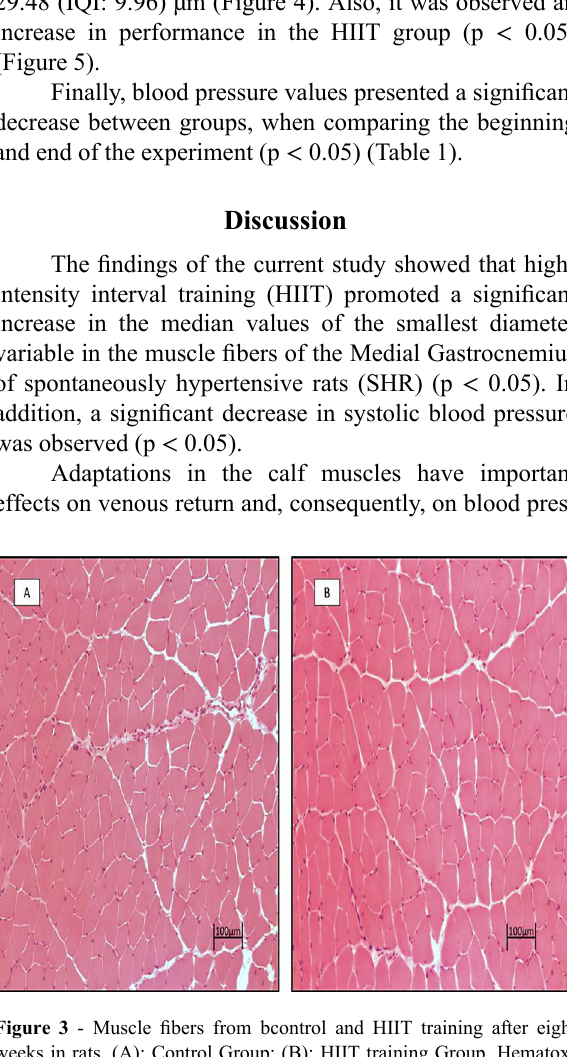
Figure 4 - Comparison between medians between control and HIIT training rats after eight weeks. (*) Statistical difference presented by the Mann Whitney test with a significance value of 5% (p < 0.05). Control Group (SHR rats, n = 10). HIIT training Group (SHR rats, n = 10). Values exposed in medians and interquartile intervals (IQI).